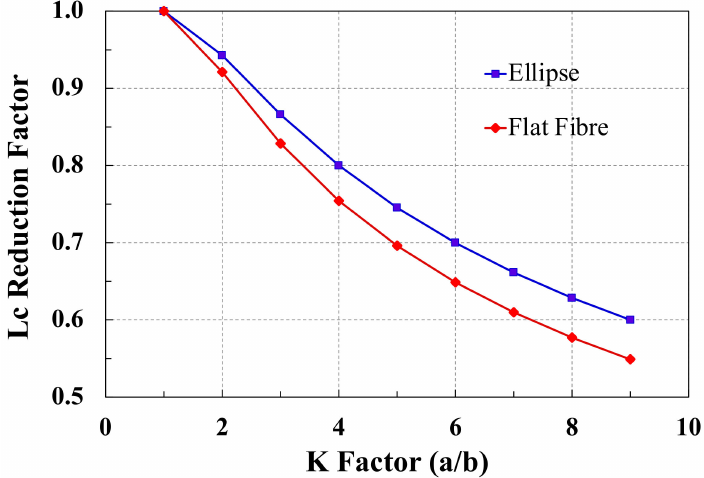
Figure 2. L c reduction factors (C) for flat and elliptical fibres versus flat flatness